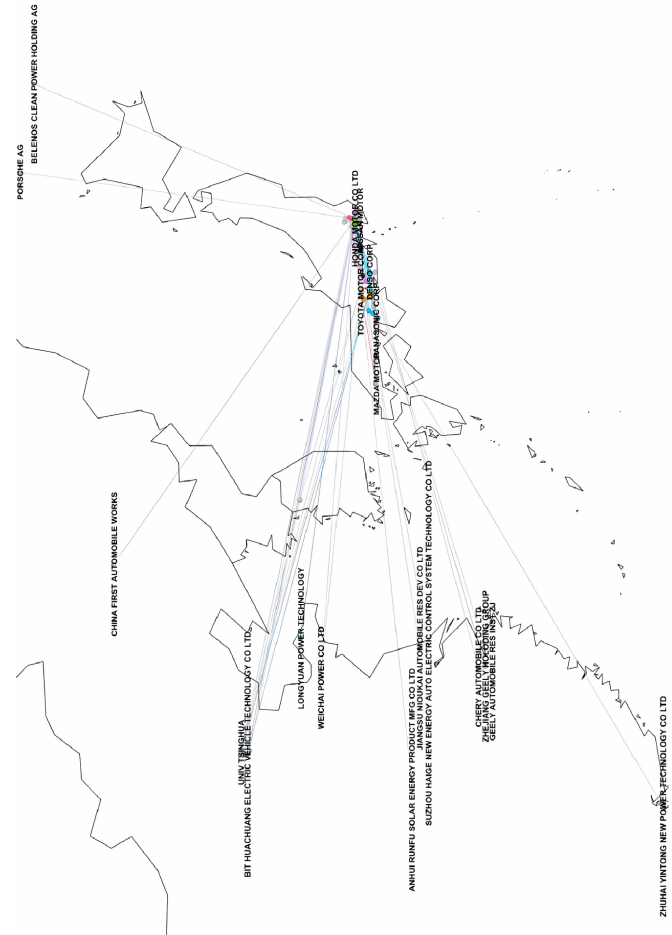
Figure 5. Geographical visualization of patent citation